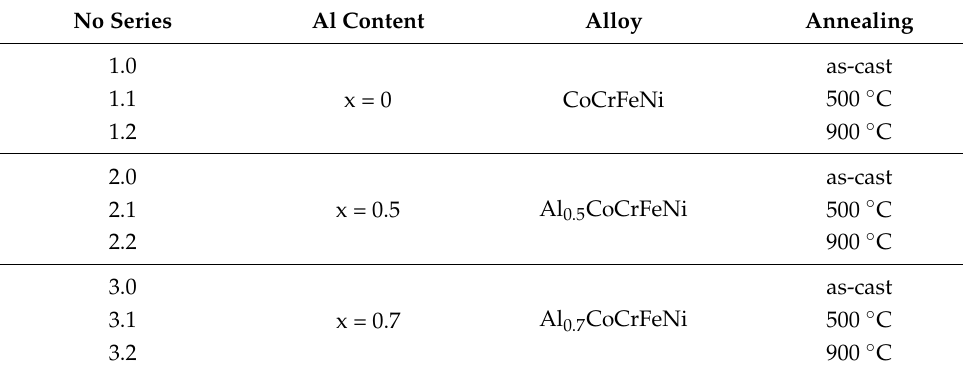
Table 1. List of Al x CoCrFeNi alloy specimens used for